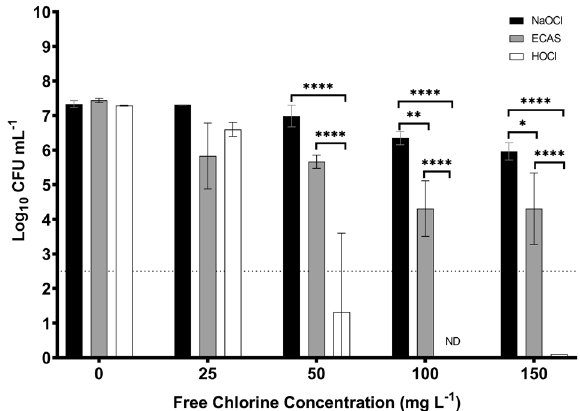
Fig. 3 Antimicrobial ef fi cacy of NaOCl, ECAS and HOCl against planktonic Escherichia coli with Dirty BSA as an inhibitory solution. Antimicrobial ef fi cacy of NaOCl [black], ECAS [grey] and HOCl [white] using standardised free chlorine concentrations against E. coli ATCC 10536 with an interfering solution of 3.0 g L − 1 BSA ( 42 British Standards Institution, 2009). Dotted line represents the minimum log reduction (5 log CFU mL- 1 ) required to demonstrate basic bactericidal activity under the experimental conditions of the assay ( n = 3 ± s.d.). Signi fi cant differences ( p -values) calculated through a two-way ANOVA with Tukey ’ s comparison post-test, with a con fi dence interval of 95% (**** p < 0.0001; ** p < 0.01; * p < 0.05). ND = not detected. Error bars represent standard deviation.